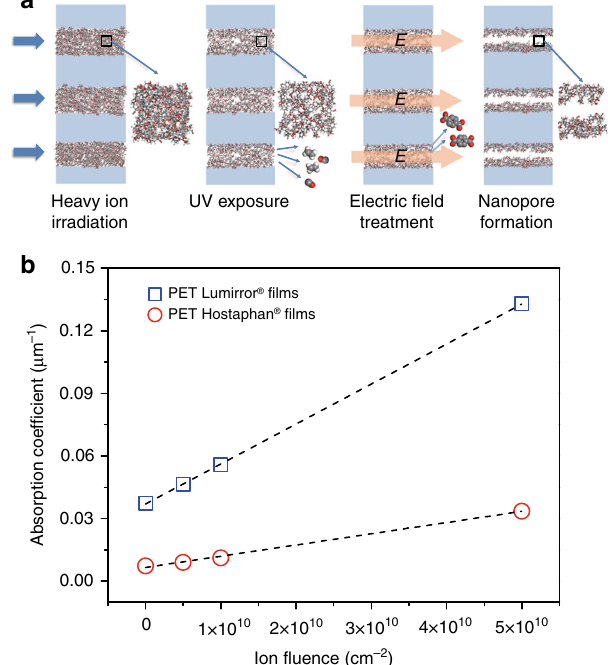
Fig. 4 Fabrication process of nanoporous membranes with the track-UV technique. a Schematic of the nanopore formation process in a thin slice of the polymer fi lm irradiated with energetic heavy ions and subsequent UV radiation. Each ion projectile produces a nanometric cylindrical track (in atomic representation) inside the polymer fi lm (light blue). Given the collimated ion beam (blue arrows), the tracks are oriented parallel and stochastically distributed. Tracks are amorphous cylinders and consist of broken polymer chains and decreased density due to the release of small volatile degradation molecules such as C 2 H 4 and CO during ion irradiation and UV-induced photochemical reactions 56 . The charged fragments such as terephthalic acids are further cleaned when an electric fi eld is applied across the membrane immersed in water. Finally, uniform nanopores form inside the core of the track. b UV absorption (at 365 nm) as a function of ion fl uence of PET Lumirror® (blue square) and Hostaphan® (red circle) fi lms. Dashed lines are linear fi